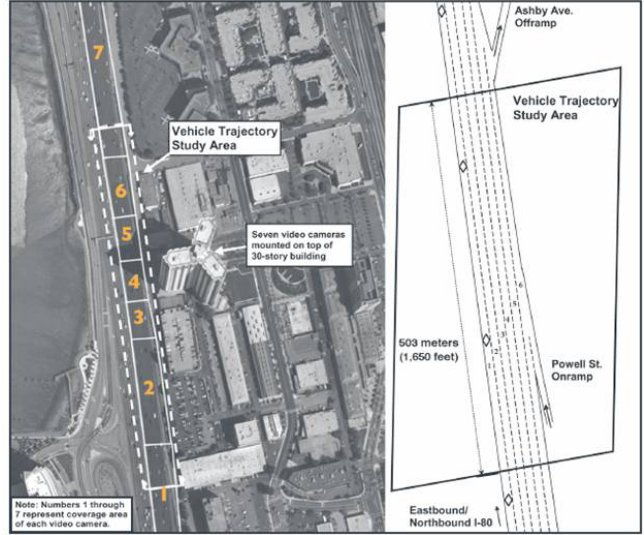
Figure 1. Top view of the US-101 freeway from which the data are extracted.